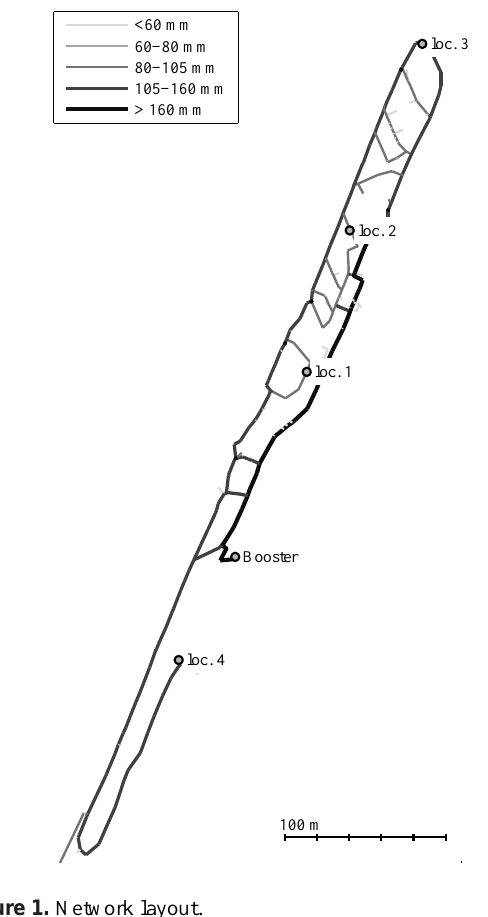
Figure 1. Network